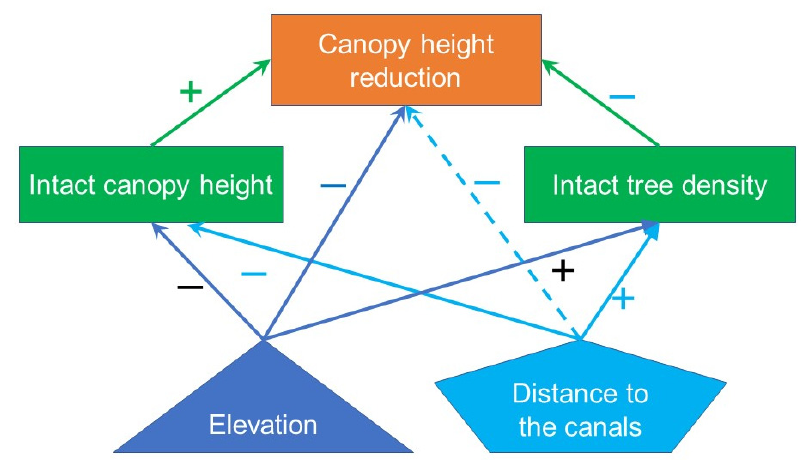
Figure 7. Connection graph showing the roles of elevation and distance to canals in the spatial variations of intact canopy height, intact tree density, and canopy height reduction by the hurricanes. The dashed line between the distance to canals and the canopy height reduction considers the 0.09 p -value in Equation (4).